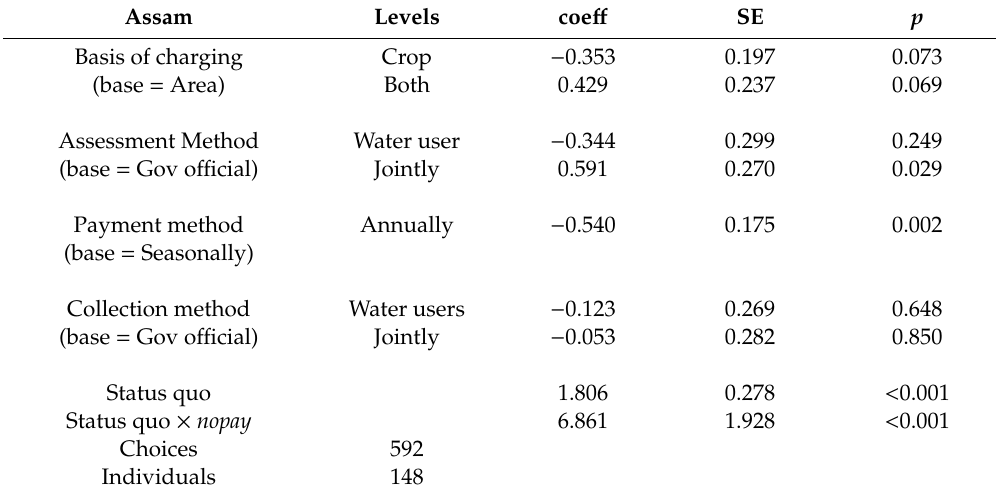
Table 7. Conditional logit estimates for preferences for irrigation payment systems: